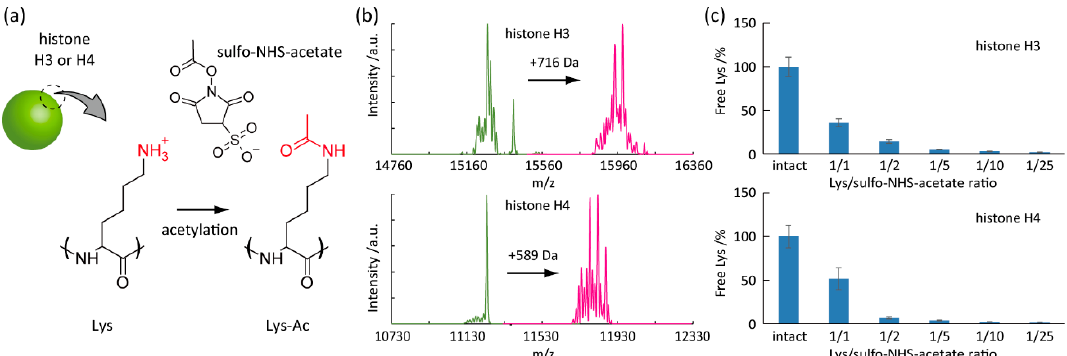
Figure 2. Model studies of histone acetylation. ( a ) Acetylation of Lys in histone subunit (H3 or H4) induced by sulfo- N -hydroxysulfosuccinimide acetate (sulfo-NHS-acetate). ( b ) Liquid chromatograph-mass spectrometry (LC-MS) analysis of histone H3 and H4 before and after treating sulfo-NHS-acetate. ( c ) Free Lys degree in histone H3 and H4 as a function of sulfo-NHS-acetate content.